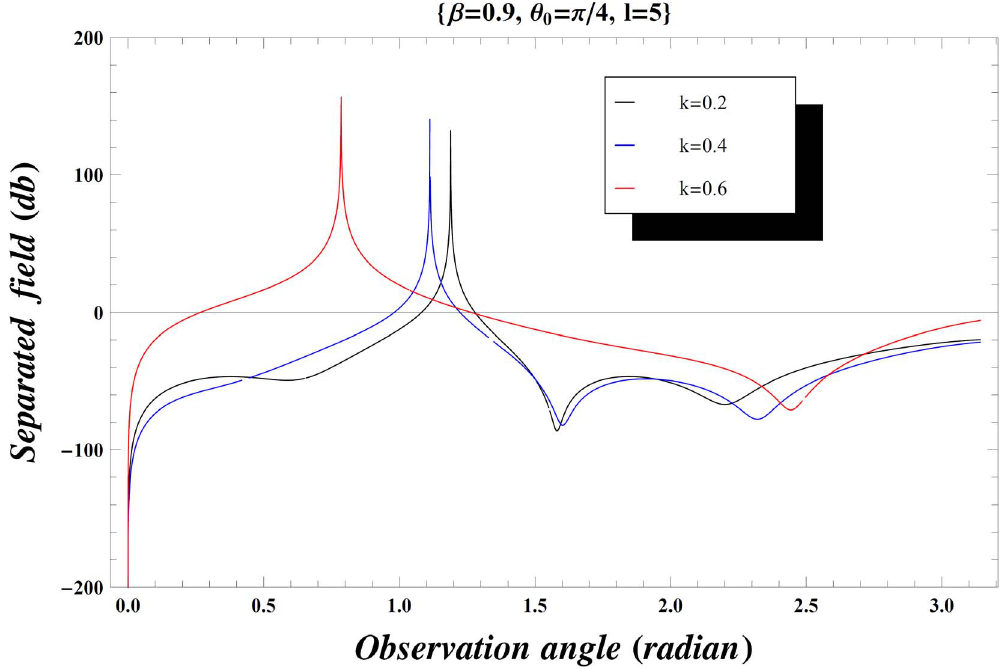
Figure 10. Separated field versus observation angle for different values of wave number k when b 1 ~ 0 : 9 .